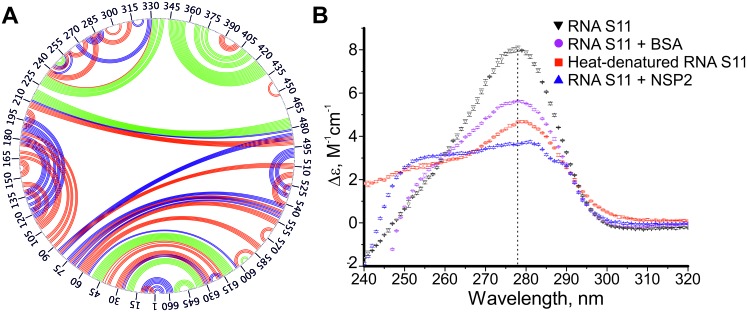
Conformational changes in S11 RNA upon NSP2 binding.(A) Overlaid circular plots of S11 RNA structures probed by RNA-RNA SELEX in the absence and in the presence of NSP2. Green arcs indicate stable base pairs that are present in the S11 RNA structure and remain unchanged upon NSP2 binding. Upon incubation with NSP2, multiple base-paired regions are destabilized and exposed (red arcs), or become less accessible due to re-formation of new intra-molecular contacts (blue arcs). (B) Circular dichroism (CD) spectra analysis of S11 ssRNA confirms RNA secondary structure destabilization in the presence of NSP2 (blue). The CD spectra of folded RNA at 37°C and thermally unfolded RNA (90°C) are shown in black and red, respectively, along with the spectra of the RNA in the presence of bovine serum albumin (BSA, shown in magenta), with an extinction coefficient similar to NSP2.